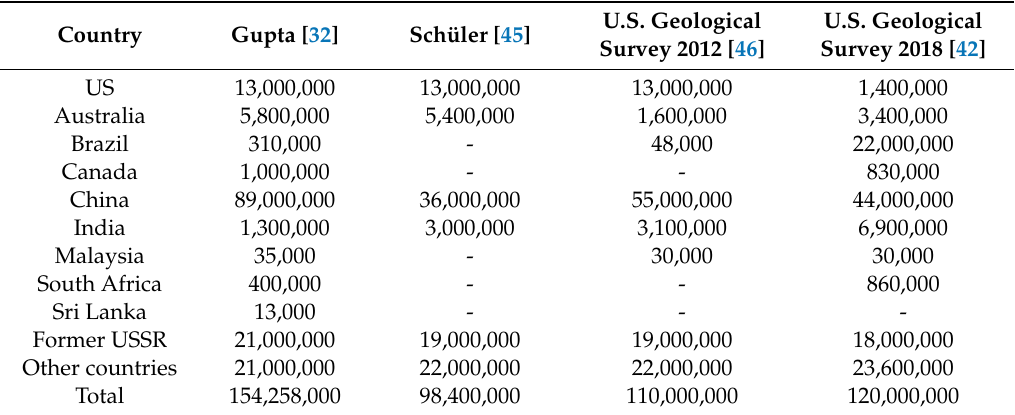
Table 2. World reserves of rare earth elements (REEs).